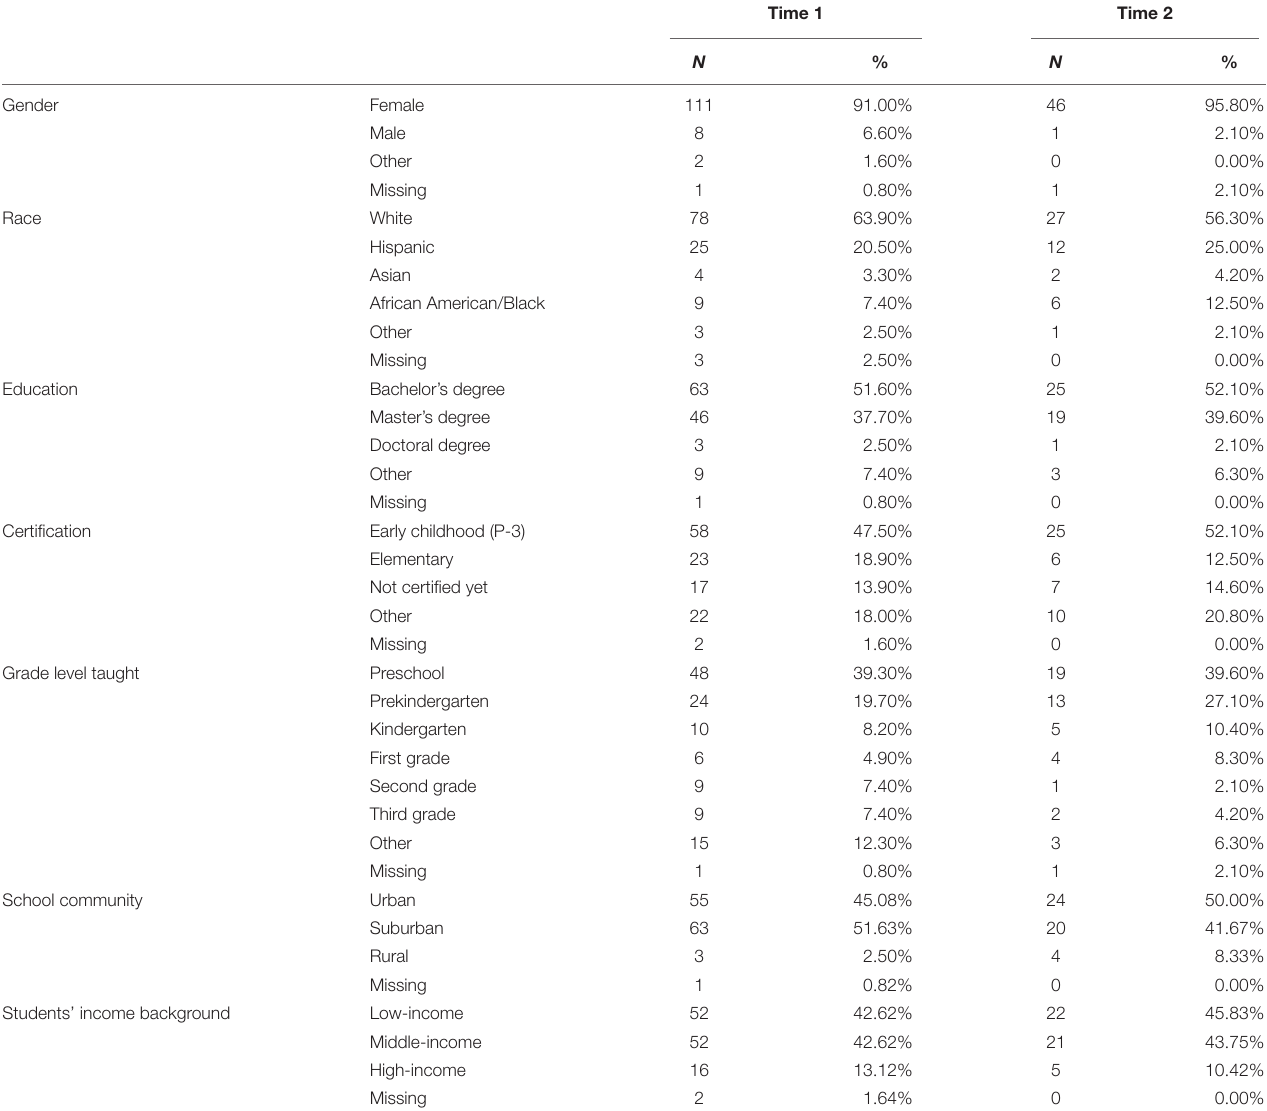
TABLE 3 | The sociodemographic characteristics of participants for both Time 1 ( N = 122) and Time 2 ( N =